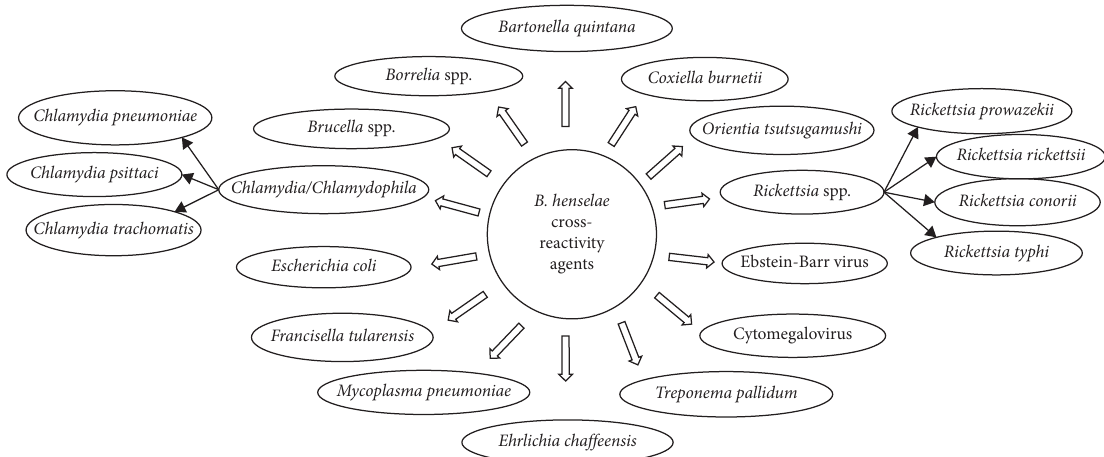
Figure 3: Infectious agents that cause cross-reacting serology with B. henselae